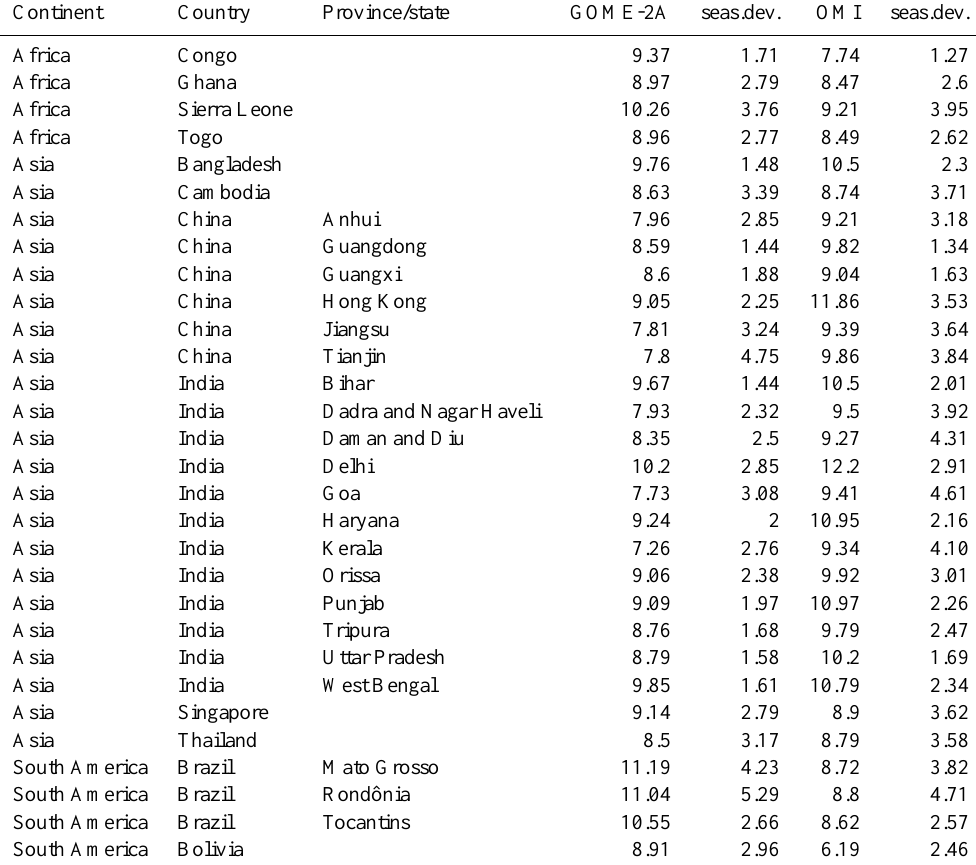
Table 2. GOME-2A and OMI largest annual mean H 2 CO columns between 2007 and 2013 (10 15 moleccm − 2 ) . Continent Country